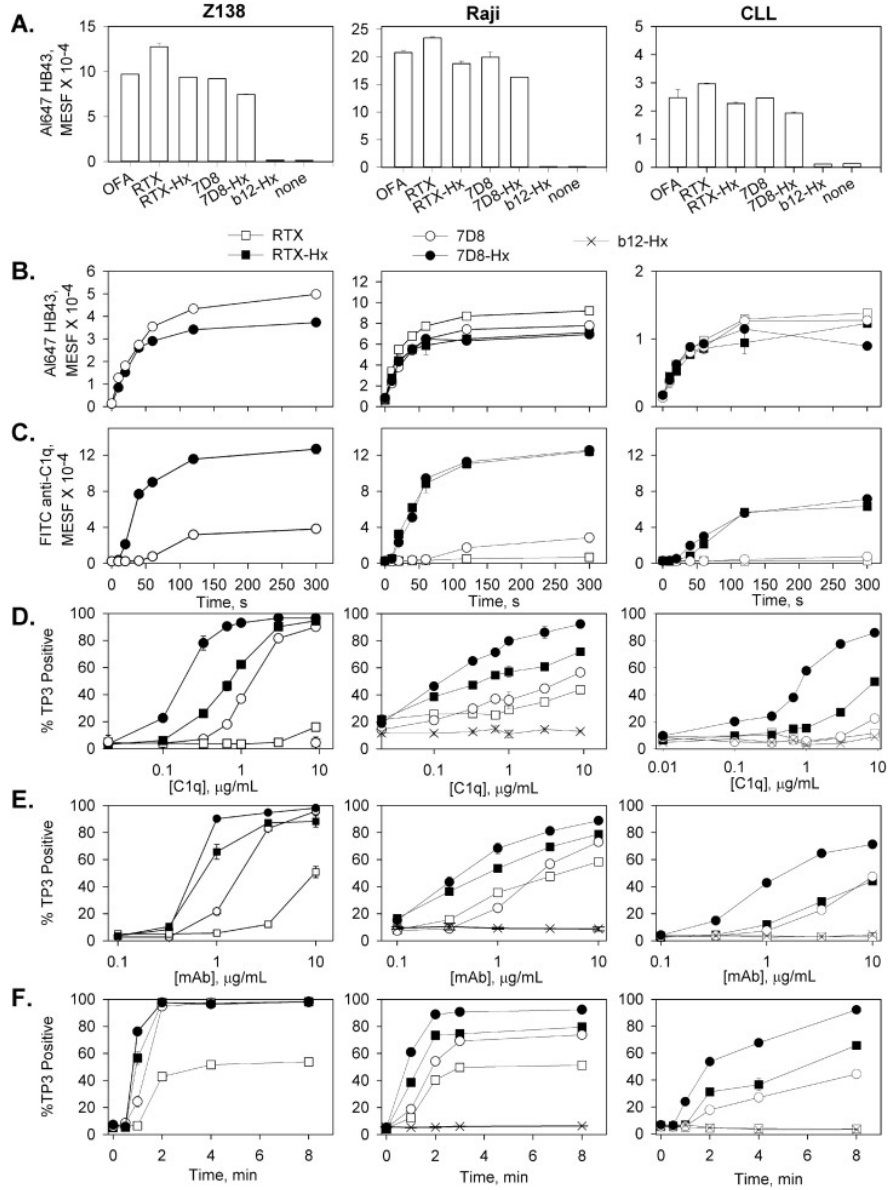
Figure 8. Hexamer-forming CD20 mAbs efficiently utilize small amounts of C1q to mediate CDC. Hexamer-forming CD20 mAbs bind to B cells and promote C1q binding, CDC and efficiently utilize small amounts of C1q to mediate CDC. ( A ) Saturating amounts of mAbs were reacted with cells for 30 min at RT in media, and after two washes, binding was evaluated by development with Al647 mAb HB43 (10 µ g / mL, 30 min on ice), specific for human IgG Fc region. All points are in duplicate, and means and SD are displayed. ( B , C ) Kinetics of mAb binding and C1q uptake were determined based on reacting mAbs (10 µ g / mL) with cells in 5% NHS for varying times at 37 ◦ C. After washing, development was based on probing with ( B ) Al647 mAb HB43 or ( C ) FITC anti-C1q antibody. ( D ) CDC with 10 µ g / mL mAb in 50% C1q-depleted serum supplemented with varying amounts of C1q for 20 min at 37 ◦ C. % TO-PRO-3 (TP3)-positive cells define % CDC. ( E ) Cells were reacted with mAbs at 37 ◦ C for 20 min in 50% NHS, and CDC was evaluated after TO-PRO-3 staining. ( F ) Kinetics of killing were determined after reacting cells with 10 µ g / mL mAb in 50% NHS for varying times. ( A – F ) Each graph is representative of 2–4 similar experiments. Results for CLL cells shown in this figure were obtained with cells from four CLL patients. Cytotoxicity for CLL cells reacted in the absence of mAbs, or plus mAb in media, or in heat-inactivated NHS, was less than 6%. [16] .